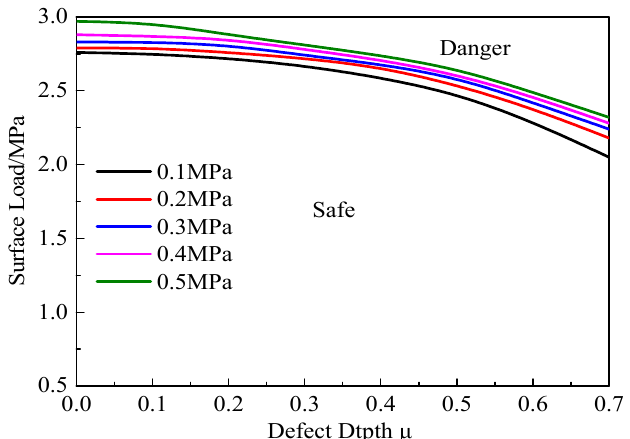
Figure 26. Defect depth-critical surface load curves under various internal pressure loads (30~60 ◦ ). Formulae for the ultimate surface load, defect depth, and internal pressure of the pipeline when the defect is located at 30–60 ◦ were obtained according to the failure evaluation curves. The R-squared of the correlation coefficient is 0.990. Here SL 30 ∼ 60 ◦ represents the critical surface load when the defect is located at 30–60 ◦ , MPa; µ represents the defect depth; P is internal pressure, MPa; a 1 , a 2 , a 3 , a 4 , a 5 , a 6 , and a 7 are the coefficients of the equation, as listed in Table